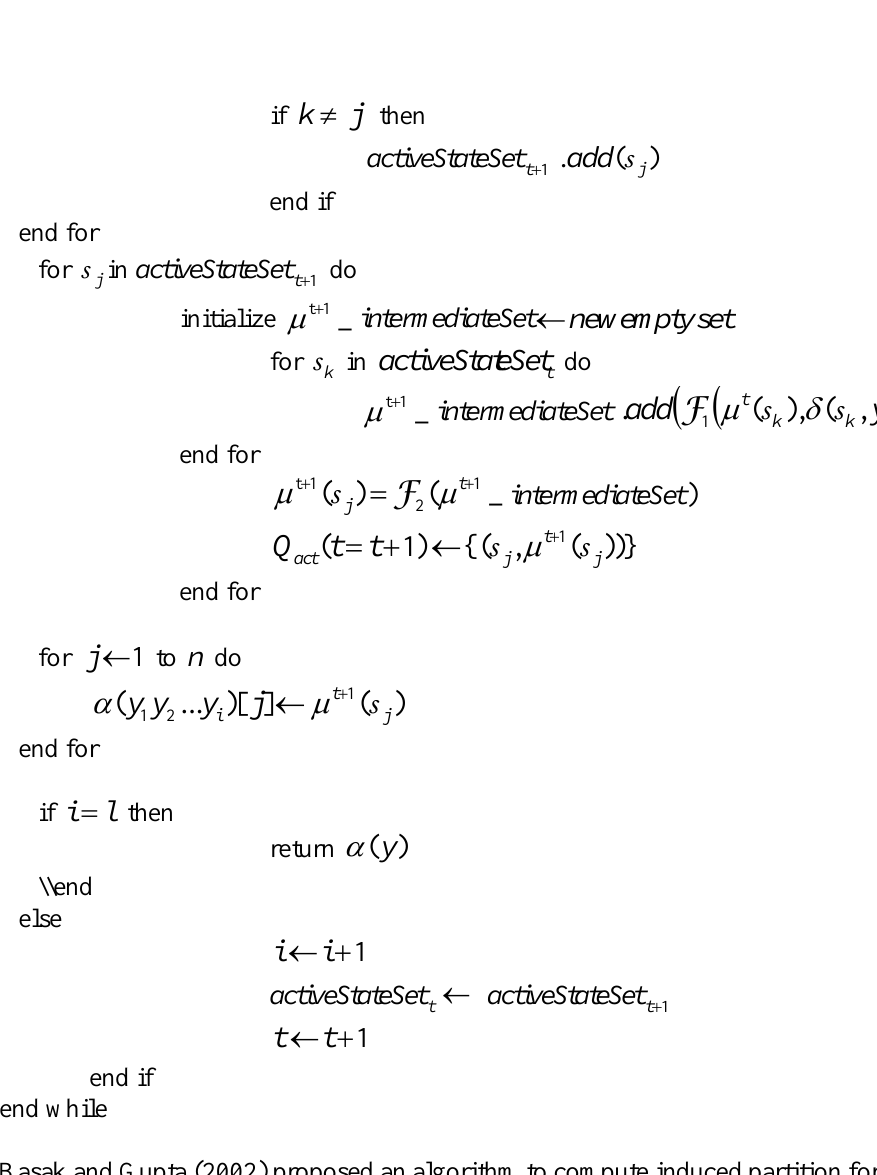
Algorithm 4.2: To compute the induced